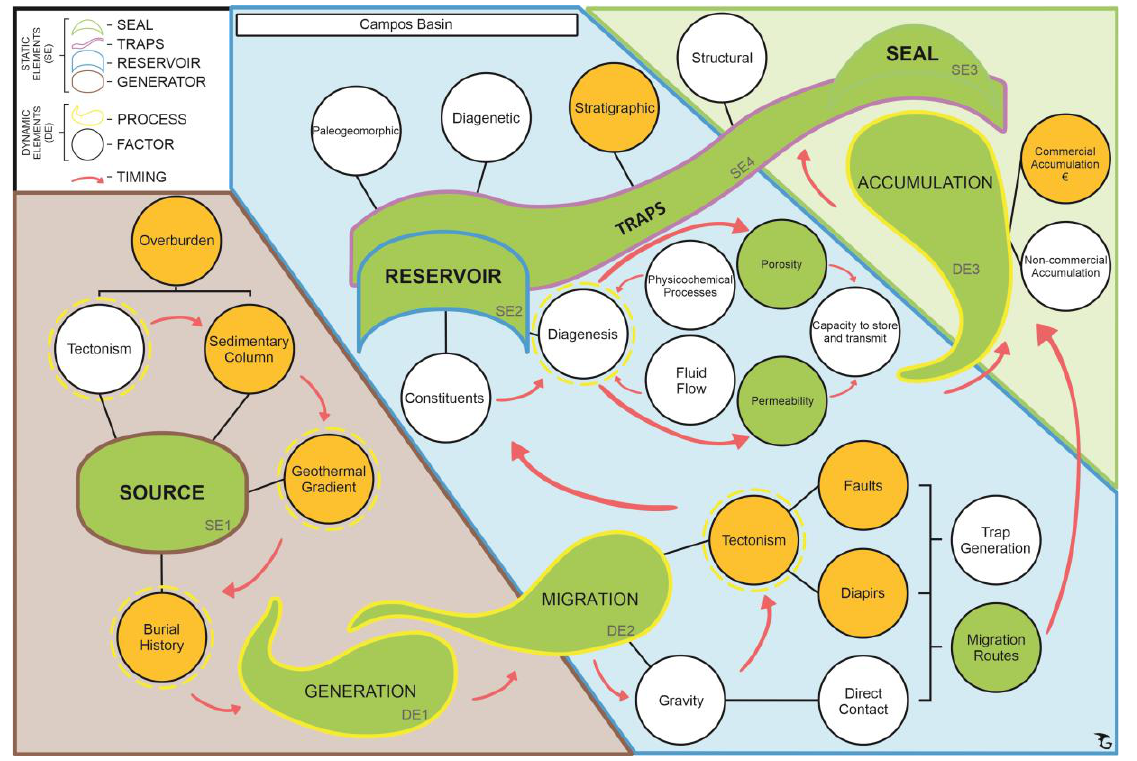
Figure 18. Illustrative scheme of the analysis of the static and dynamic elements in the study of the Carapebus Formation’s reservoir in the Campos Basin. Legend: Elements, factors and processes that were successful, in green; factors and processes that were relevant in the formation of the petroleum system, in orange; and factors and processes that were not relevant in the formation of the petroleum system, in